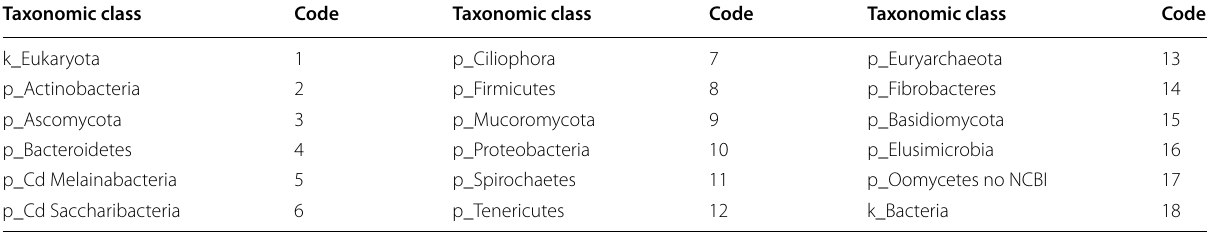
Table 2 Codification of the taxonomies for the sharing networks